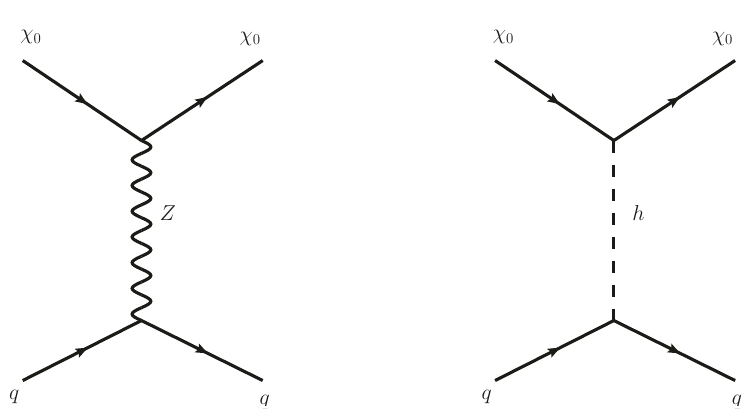
Figure 17 . Feynman diagrams contributing to the SI direct detection cross